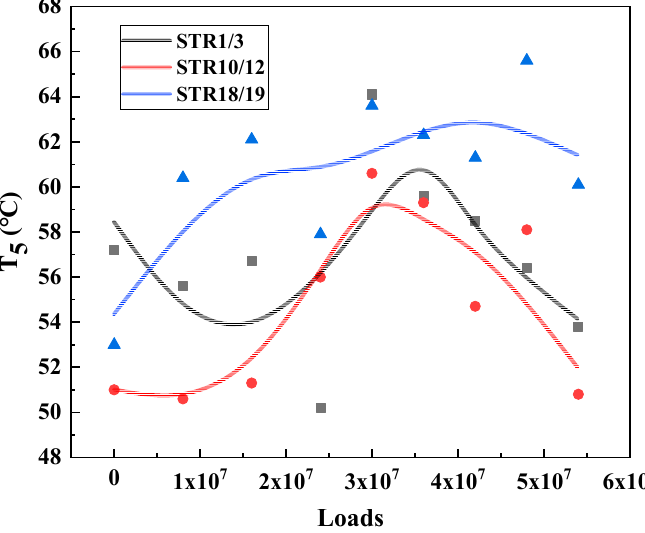
Figure 17. Characteristic temperature T 2 for the three types of structures.